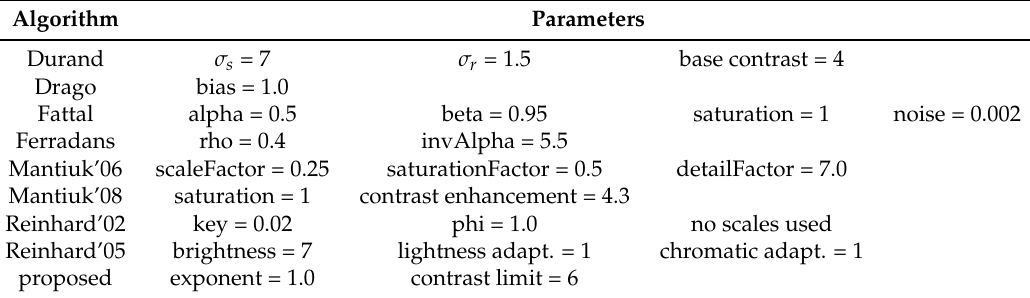
Table 2. Parameter sets for the tone mapping operator.